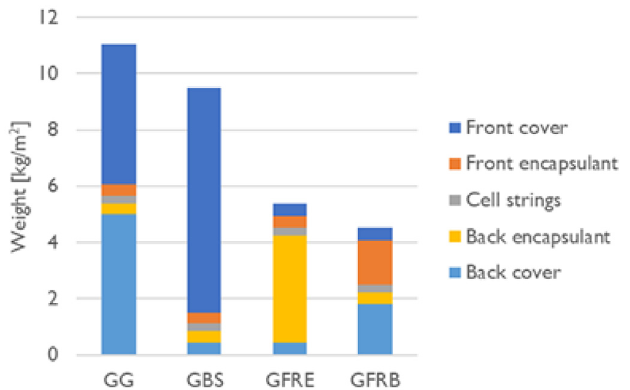
Fig. 1. Impact of the different options on overall weight of the module; the different buildups for GFRE and GFRB are explained in the following respective sections.